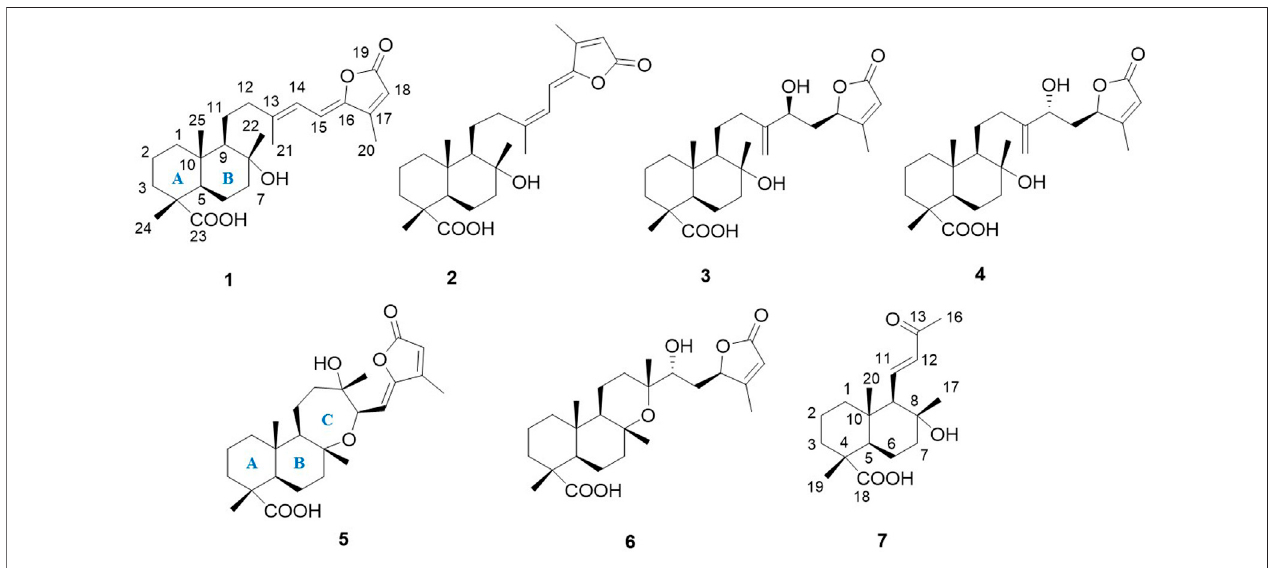
FIGURE 1 | Chemical structures of compounds 1-7 .